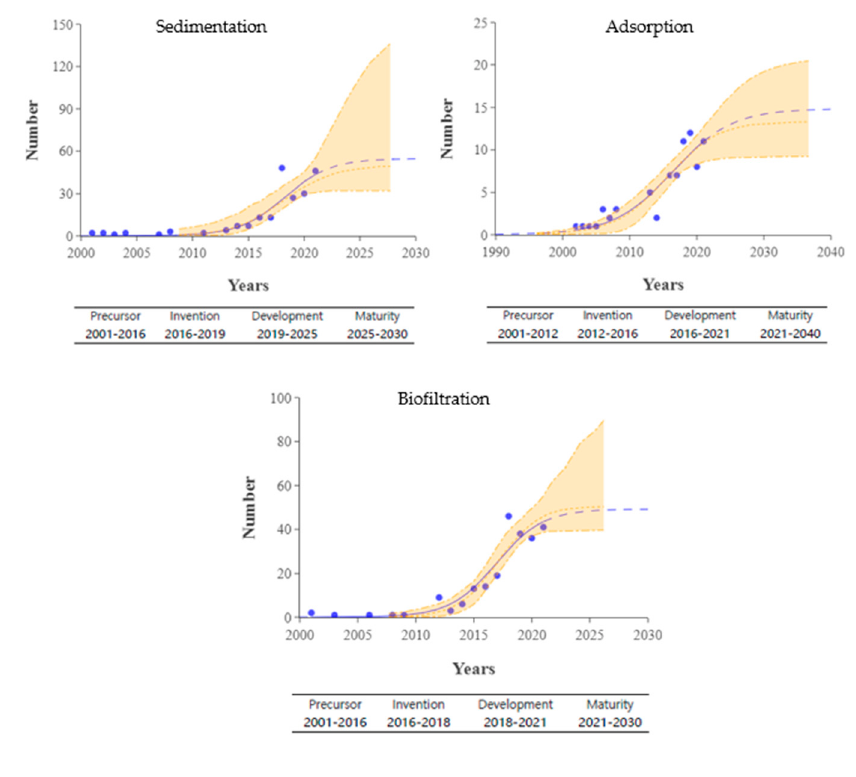
Figure 18. S-curves for treatment in patents.